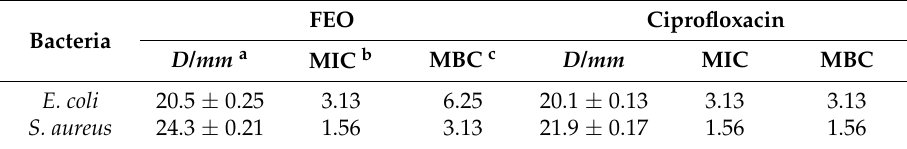
Table 1. Antibaterial activity (ZOI, MIC, and MBC) of the FEO (mean ± SD).